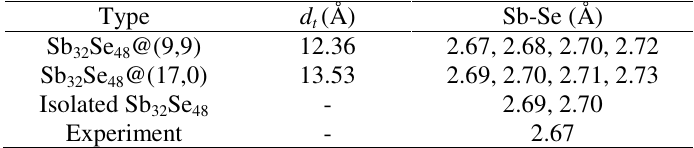
Table 4. Structural parameters (bond angles) calculated for Sb